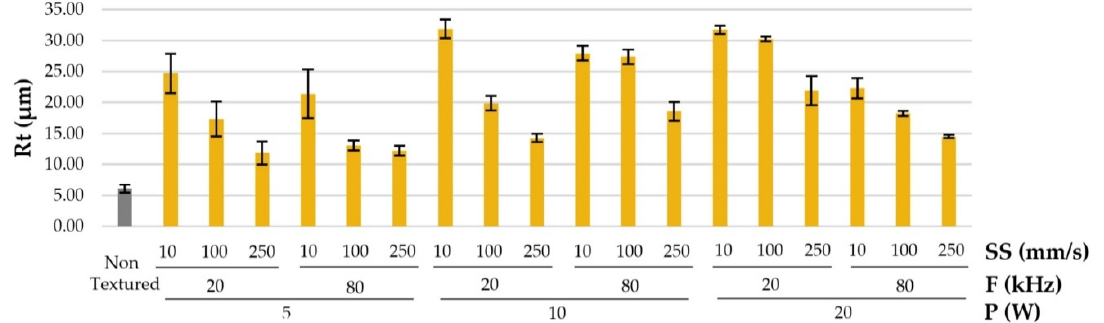
Figure 8. Rt values obtained in laser textured tests.